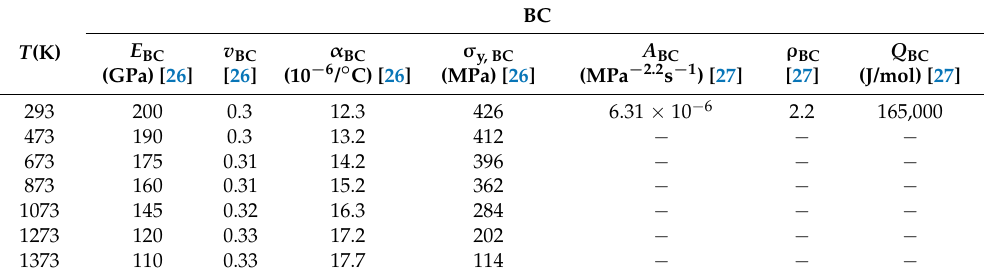
Table 2. Material properties of BC.